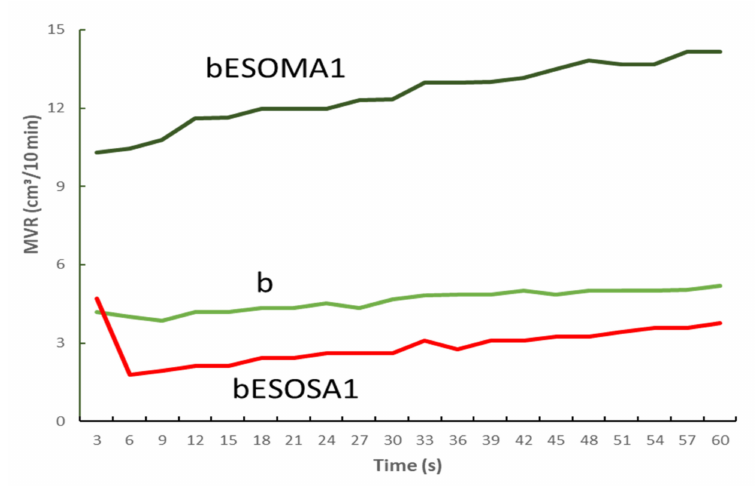
Figure 7. MVR trend of the PLA/PBSA 60/40 blend (b), the b blend with ESO + MA (bESOMA1) and the b blend with ESO + SA (bESOSA1).